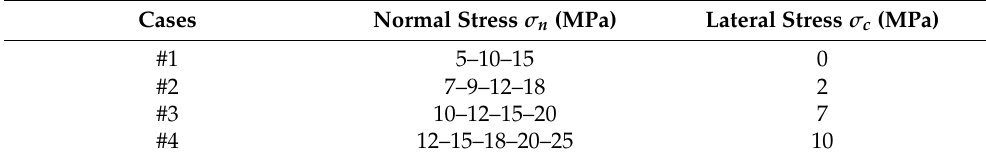
Table 3. The shear test loading scheme. Cases